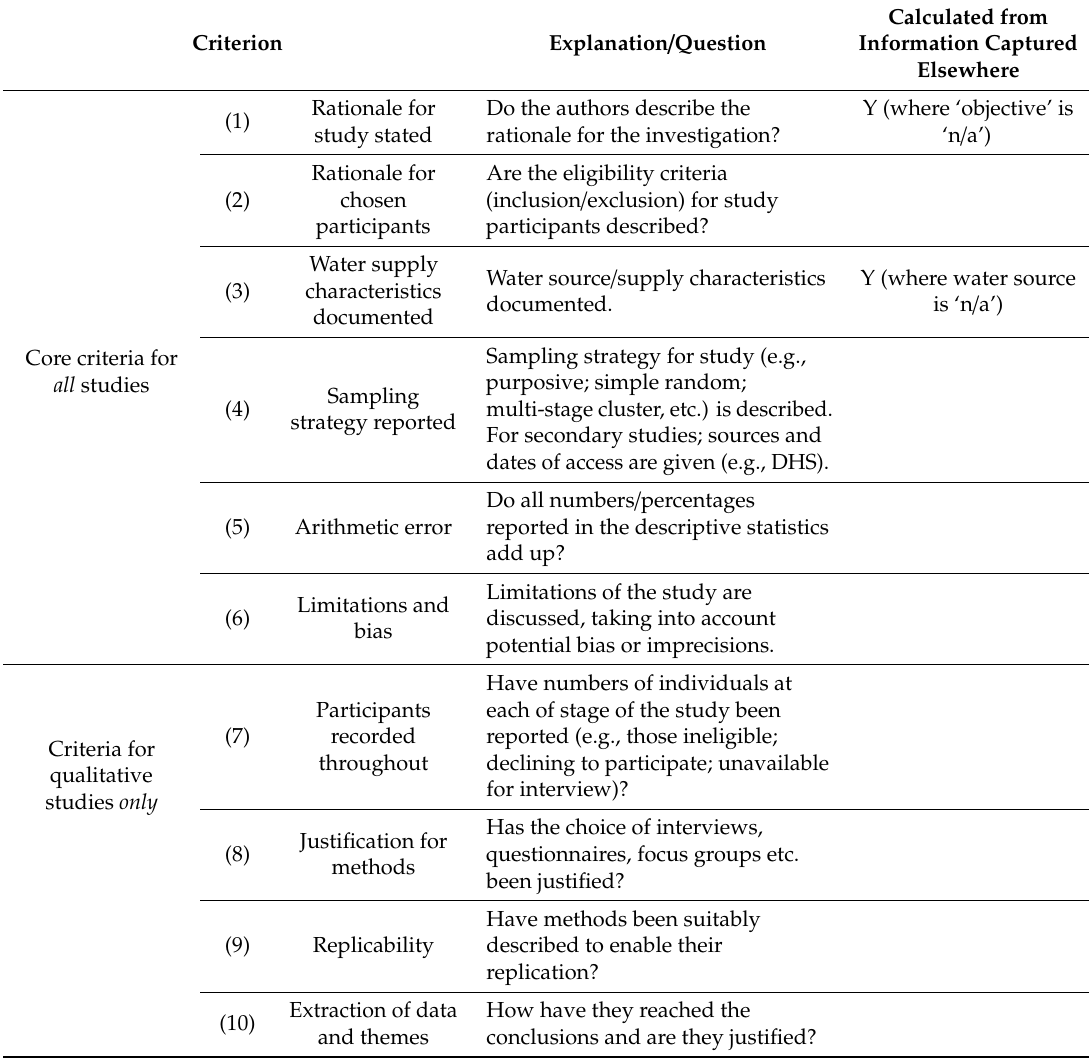
Table A2. Study Quality Ranking and